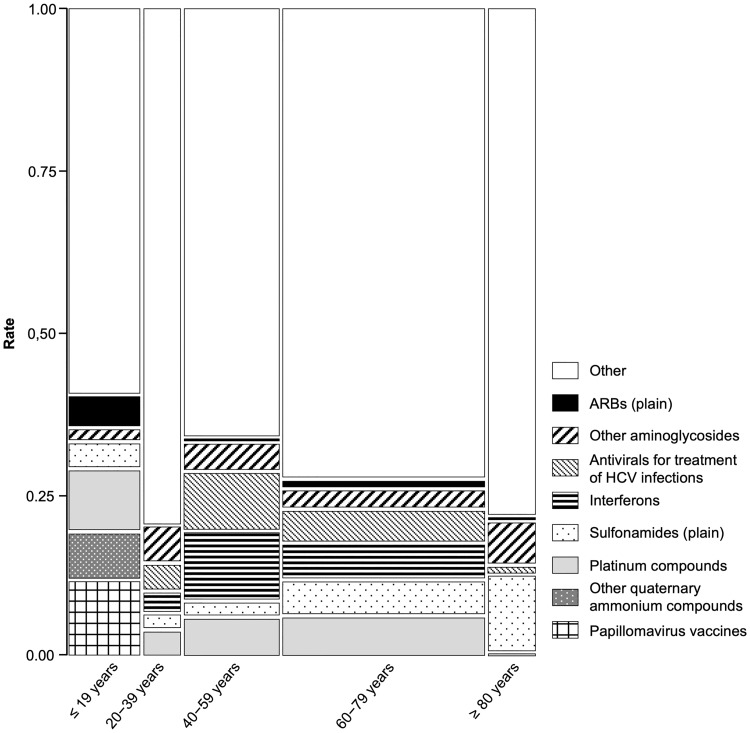
Mosaic plot of drug-induced hearing loss.